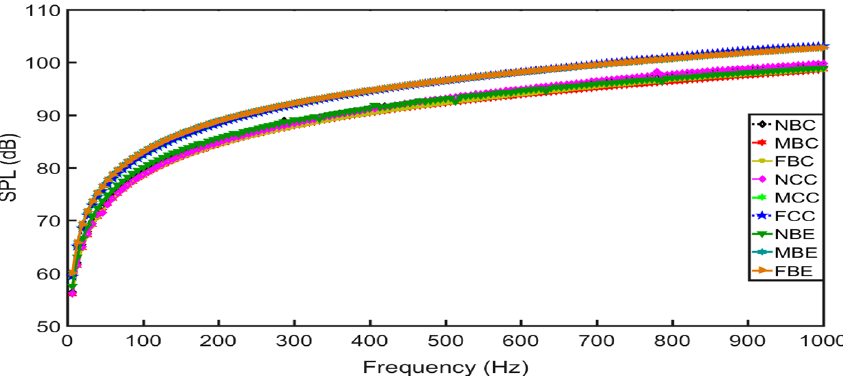
Figure 12. Maximum sound pressure level curve along the entire frequency range for all sound source